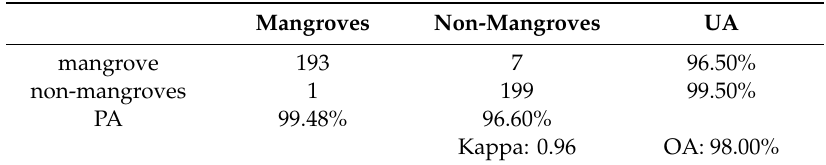
Table 2. Confusion matrix and mangrove classification accuracy. OA denotes overall classification accuracy; UA denotes user’s accuracy; PA denotes producer’s